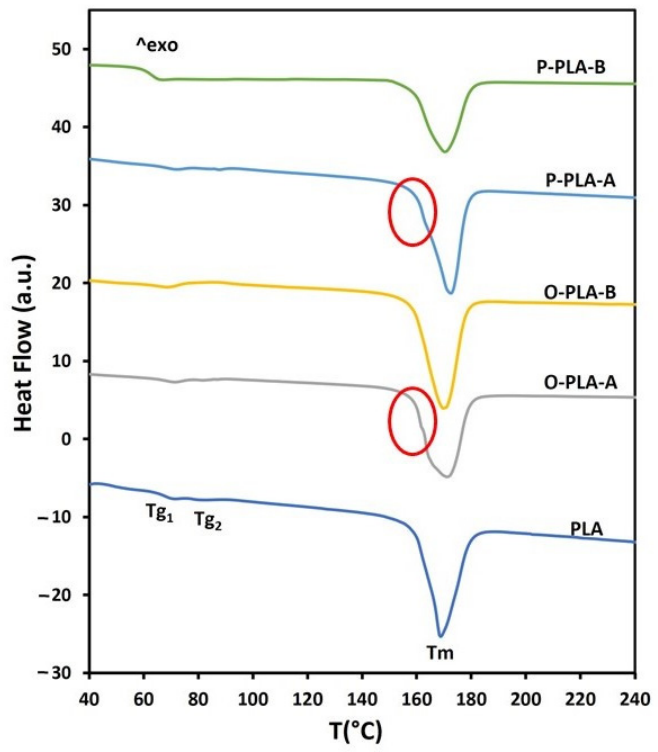
Figure 4. DSC thermograms for neat and functionalized PLA flat tapes obtained by reactive extru- sion. Table 6. DSC characteristic parameters of neat and functionalized PLA flat tapes by reactive extru- sion.